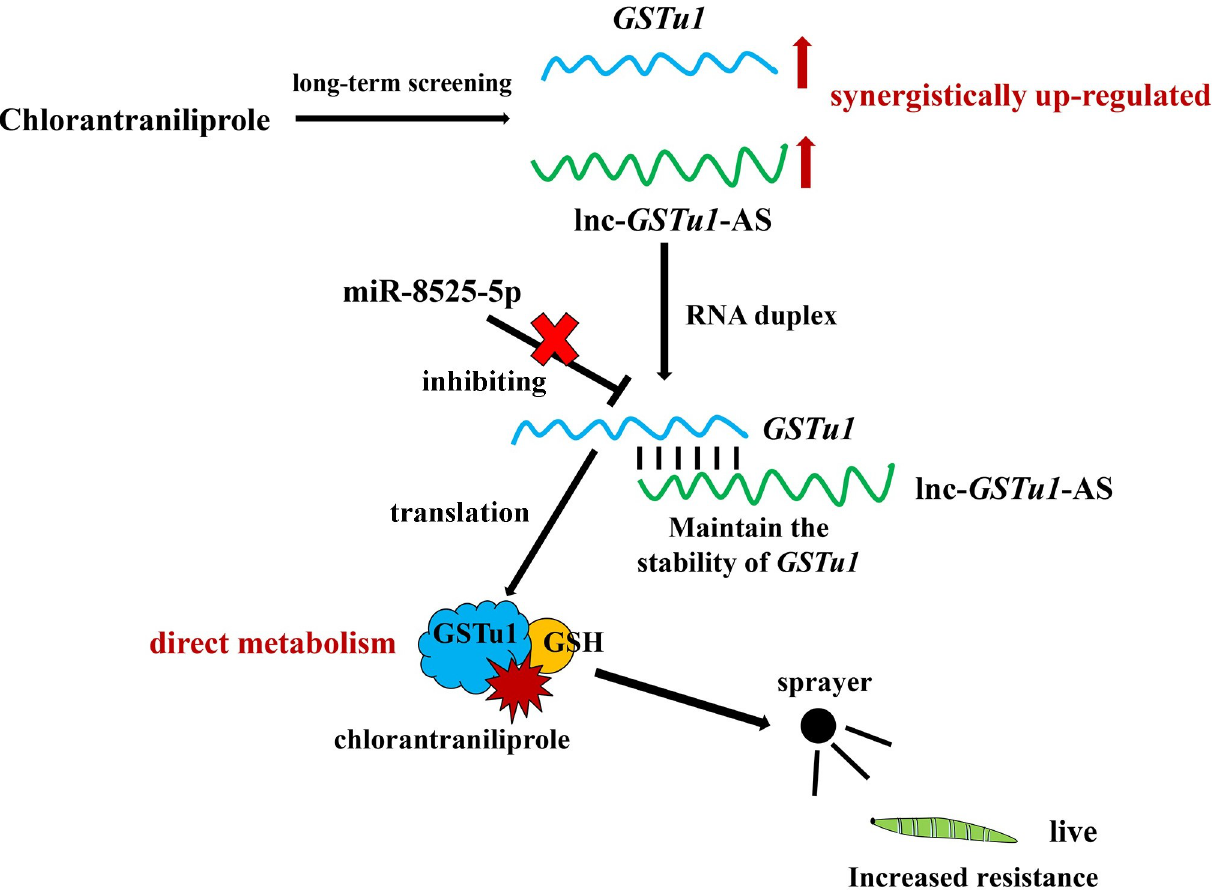
Fig 9. A schematic illustration of the proposed model depicting the role of lnc- GSTu1 -AS in regulating GSTu1 mRNA stability.